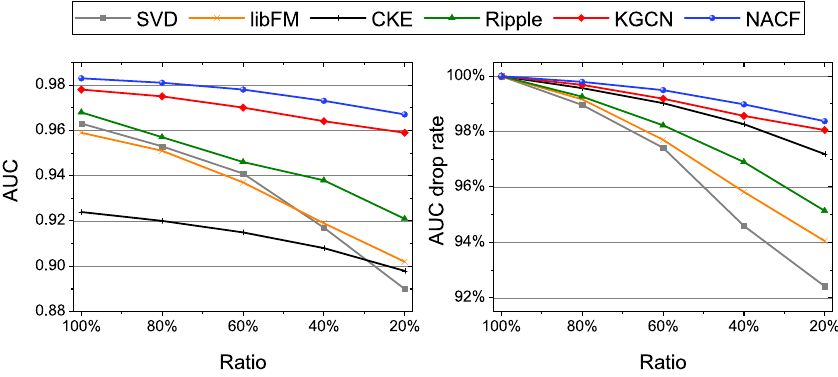
Figure 5. Model performances in cold start scenarios.